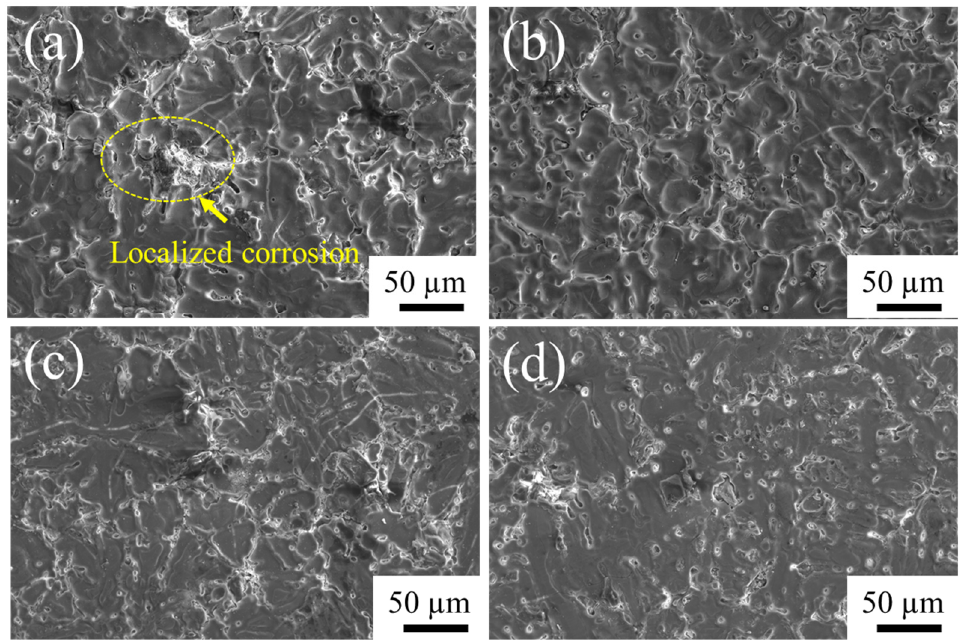
Figure 15. SEM micrographs of A535 specimens after the electrochemical corrosion testing in 5 wt.% NaCl solution: ( a ) 2-N, ( b ) 4-N, ( c ) 2-S, and ( d ) 4-S.